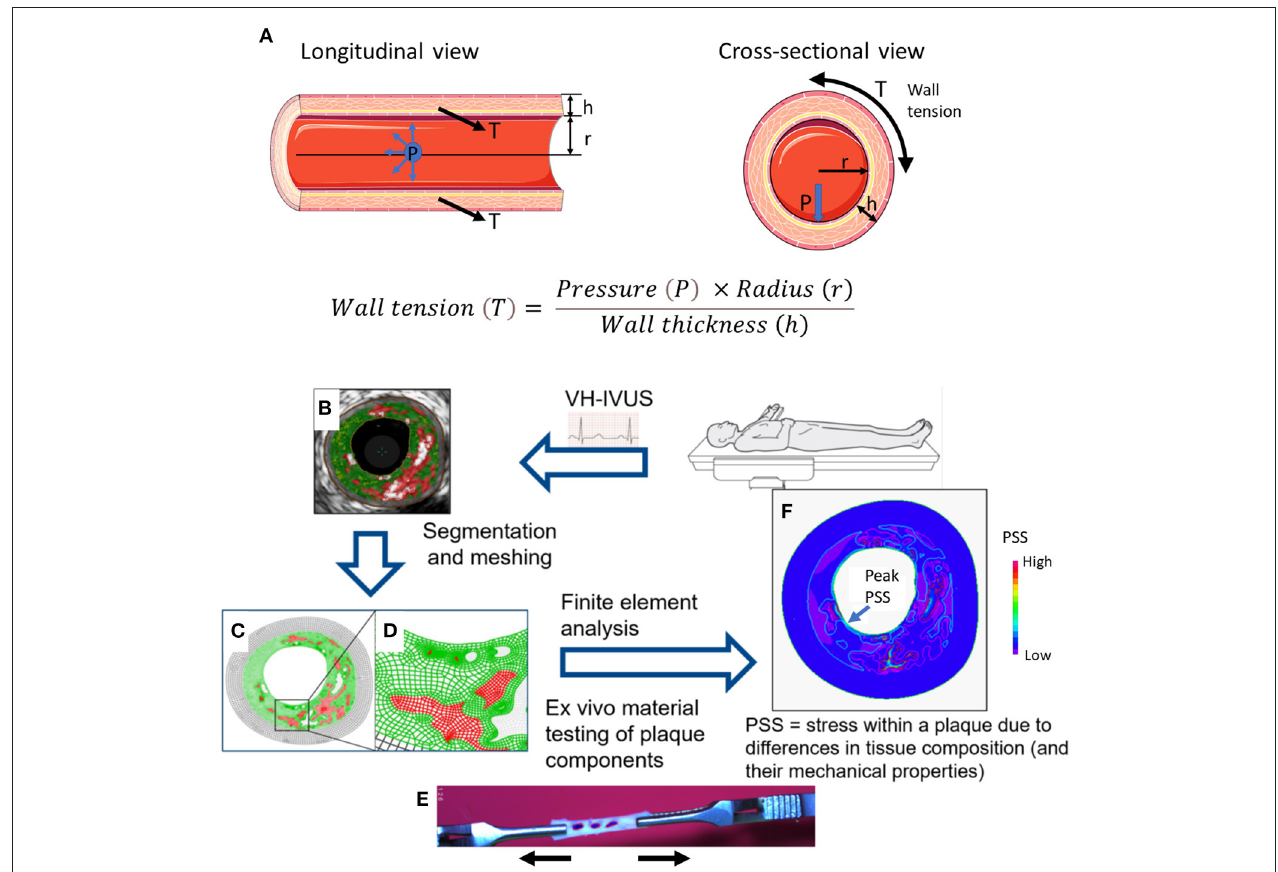
FIGURE 1 | Modeling of plaque structural stress. (A) The law of Laplace describes the relationship between transmural pressure (P) and wall tension (T). In a (cylindrical) blood vessel, there is a simple relationship between pressure and circumferential wall tension/stress. The law gives the average tension over the wall, but holds only for simple geometries. h = wall thickness; r = radius. Example of steps involved in computational modeling to calculate plaque structural stress (PSS): (B) Suitable images (e.g., virtual histology intravascular ultrasound, VH-IVUS) showing plaque structure and components generated from in vivo or ex vivo studies; (C,D) Images undergo segmentation and meshing process; (E) Plaque material properties are obtained from ex vivo tensile testing of plaque components; (F) Finite element analysis (FEA) utilizes plaque geometry, structure, components, material properties, and haemodynamic conditions to generate a numerical solution of PSS. Adapted from Brown et al.